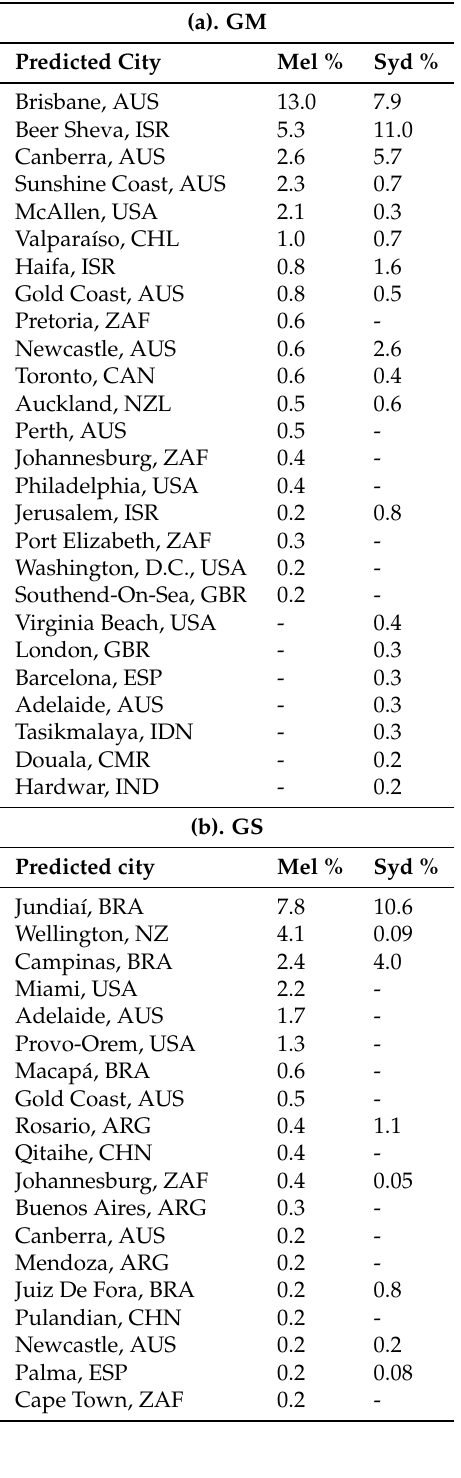
Table 2. Top 20 cities similar to Melbourne and Sydney. The table shows the percentage of evaluated locations predicted to be a certain city for GM, GS, and GSV-BSV neural